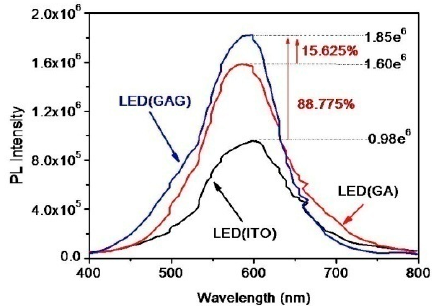
Figure 9. The photoluminescence (PL) spectra of light-emitting diodes (LED) with indium tin oxide (ITO), with graphene-Ag (GA) and with GAG.